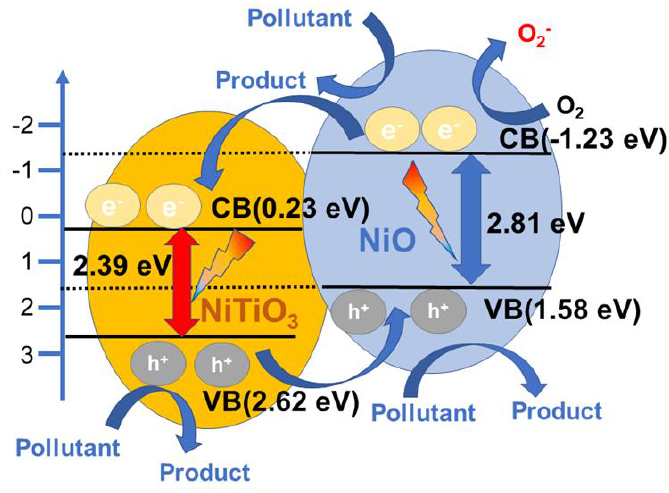
Figure 9. Diagram of the photocatalytic mechanism of NiO–NiTiO 3 composite nanofiber films.